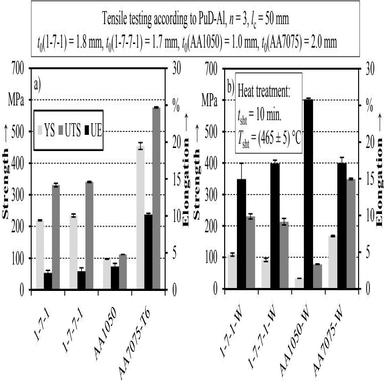
Mechanical properties of the multilayered material 1-7-1, 1-7-7-1 and the alloys AA1050 and AA7075 in as-delivered condition (a), left) and after heat treatment ((b), right).